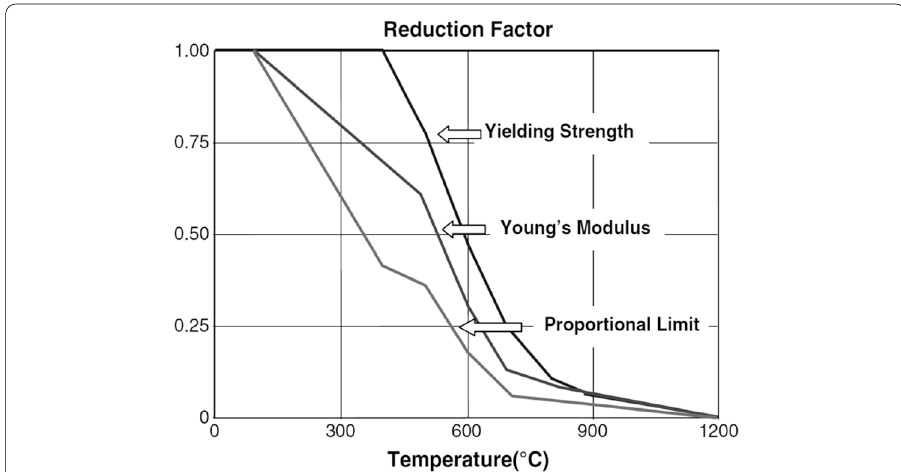
Fig. 6 Reduction factors of steel properties at elevated temperatures [39]